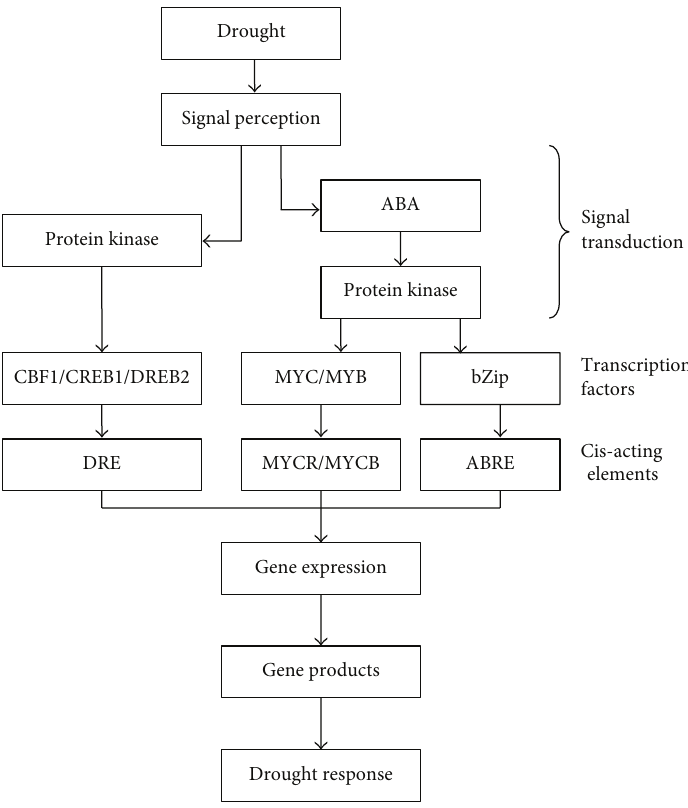
Figure 1: Signal transduction and gene expression in plant response to drought